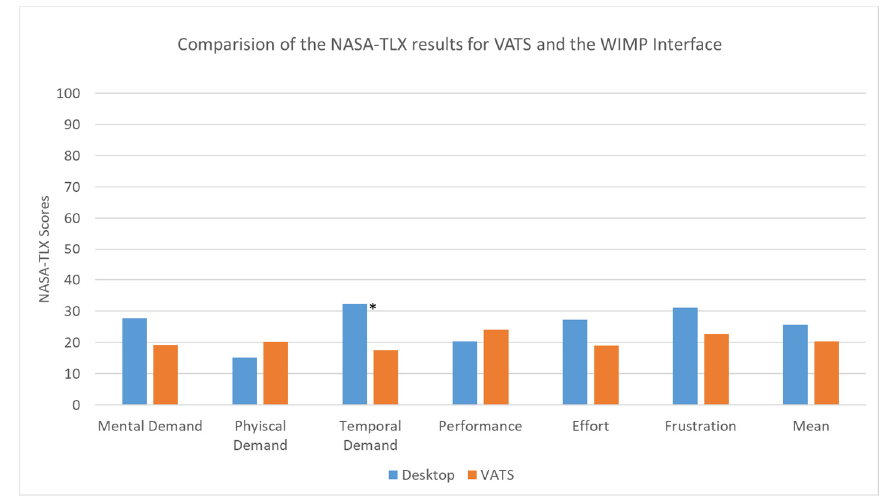
Figure 11. Results of the NASA-TLX for each dimension.